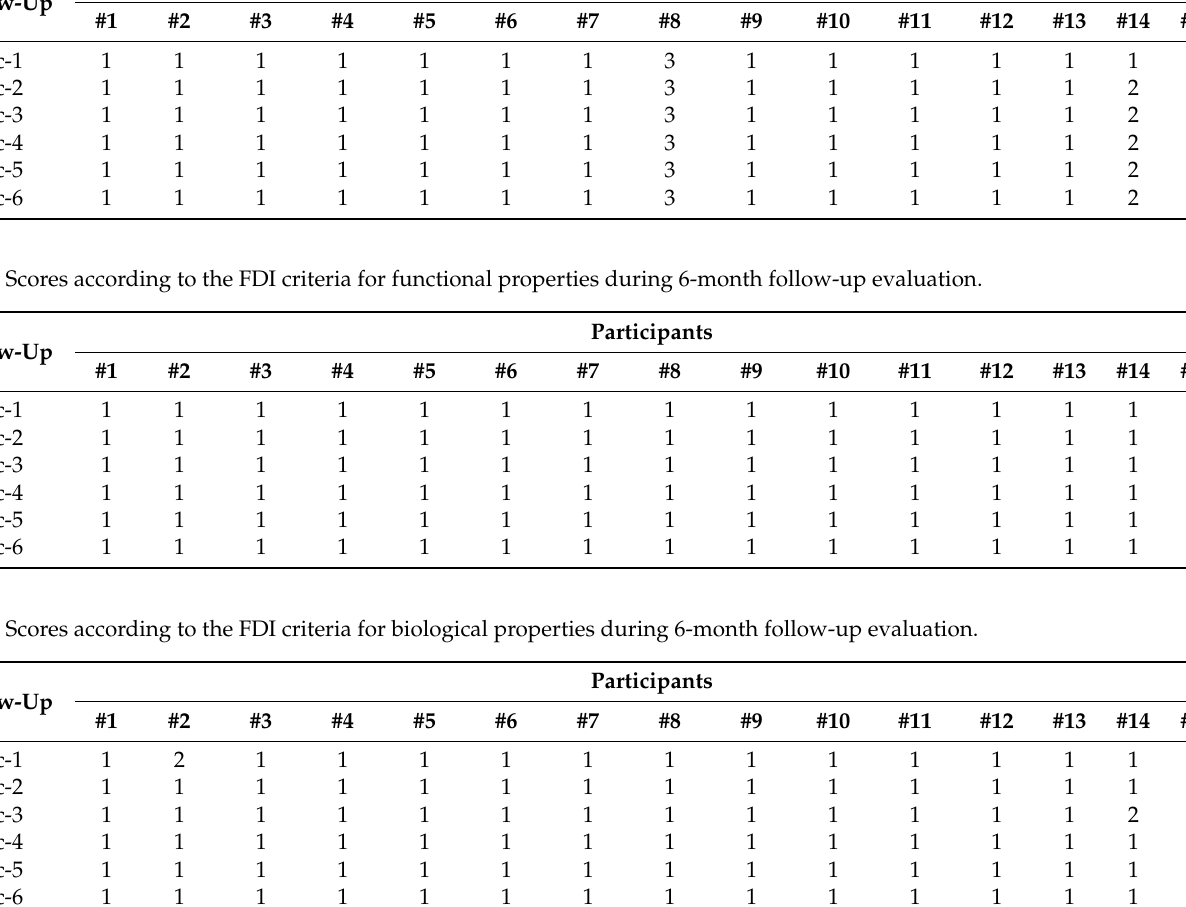
Table 4. Scores according to the FDI criteria for esthetic properties during 6-month follow-up evaluation. Follow-Up